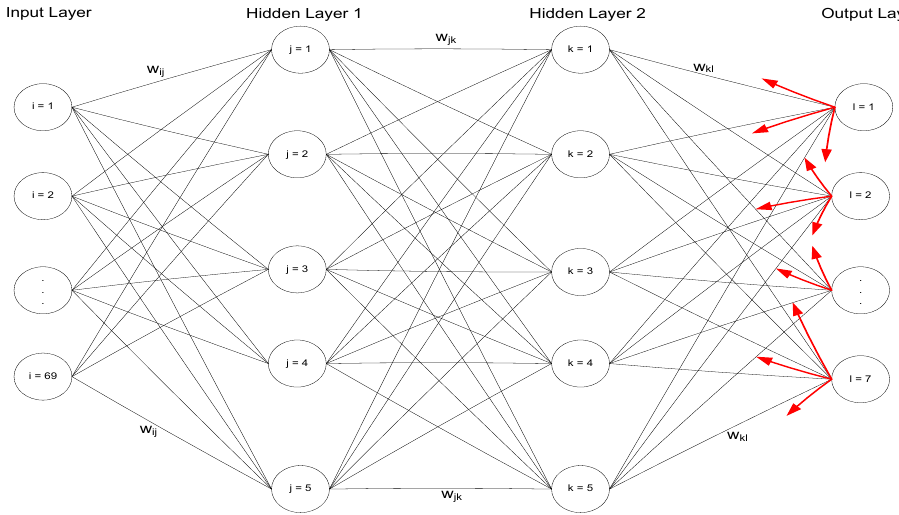
Figure 2. Forward pass and backward pass using the National Corruption Survey data.